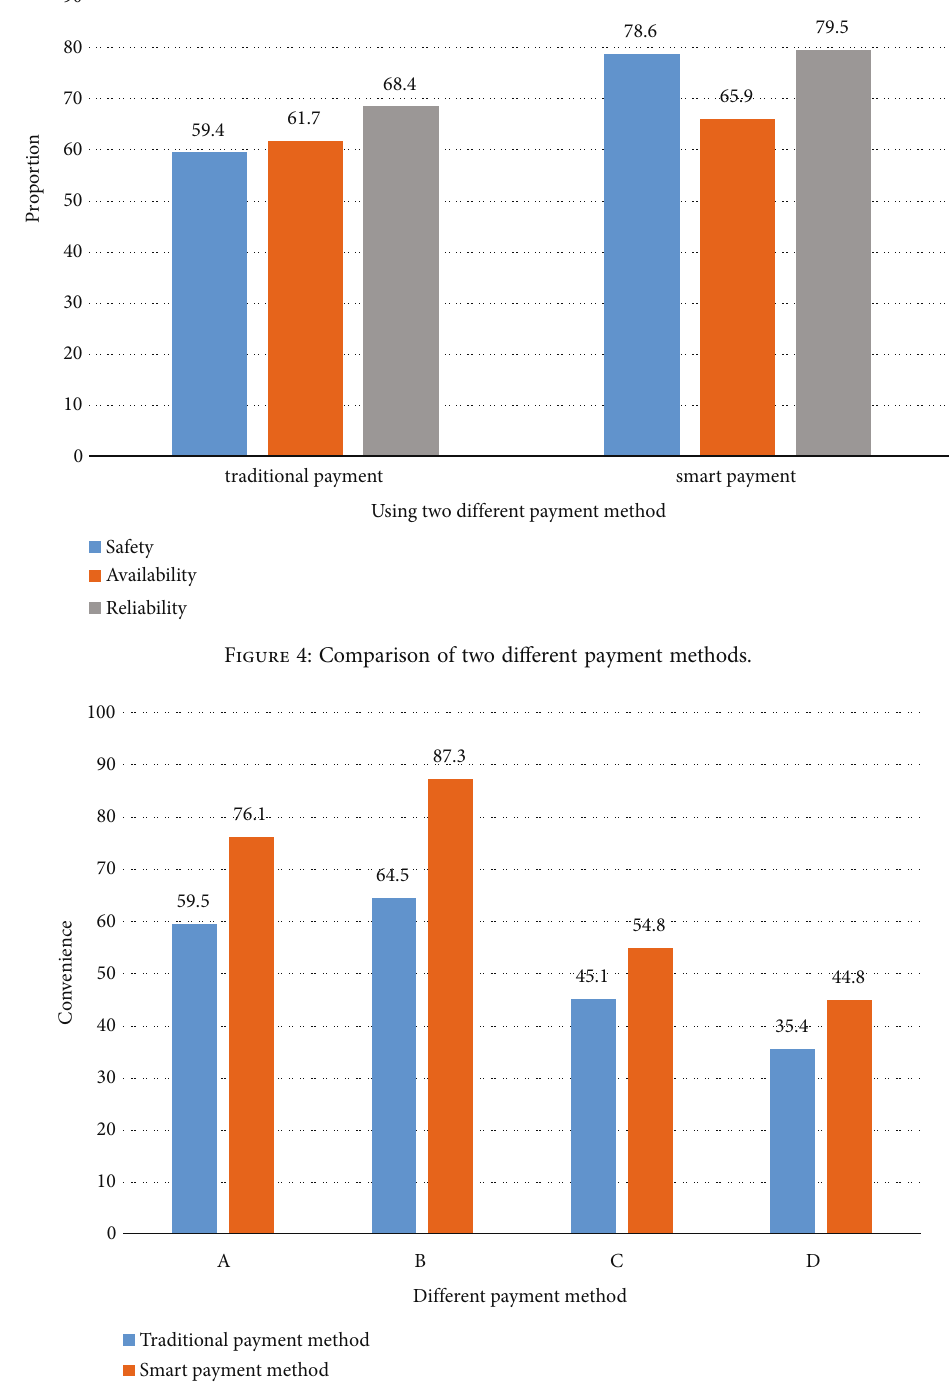
Figure 5: Convenience comparison of two di ff erent payment